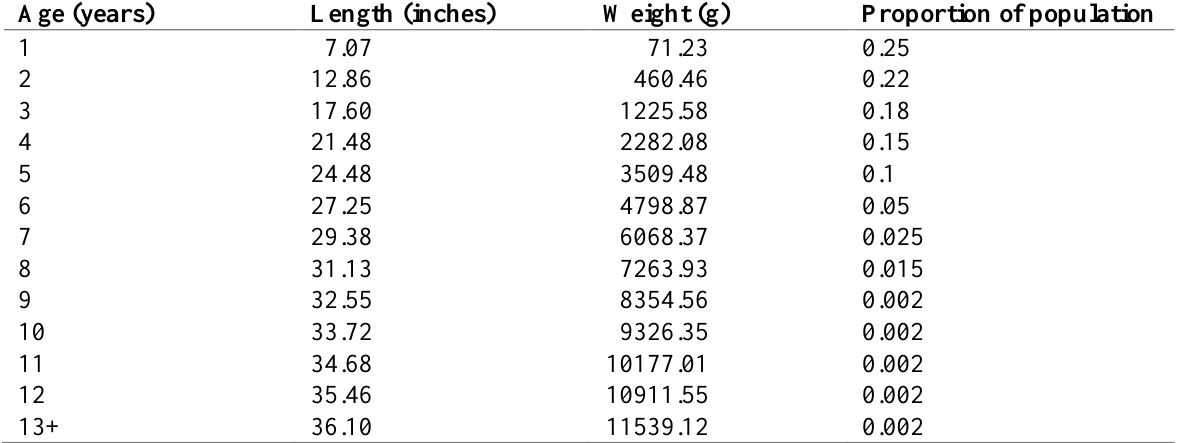
Table A1.1. The age and size distribution used to convert piscivorous fish biomass (g/m2) to a number of fish (estimated from NJ Division of Fish & Wildlife 2010, Sharov et al. 2013). Weight was estimated using a striped bass length-weight equation (Kimmerer et al.